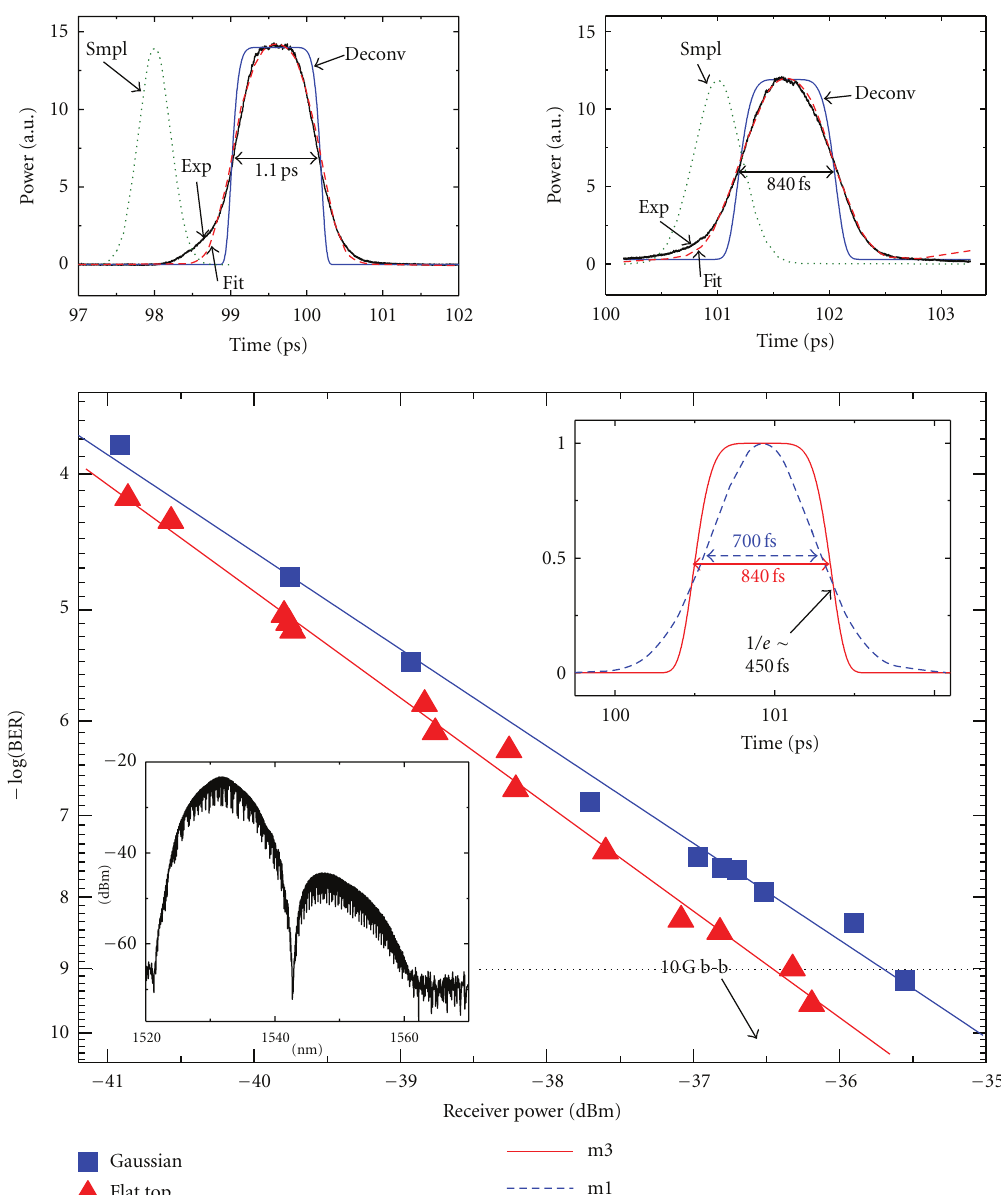
Figure 16: Flat-top pulses and 640Gbit/s demultiplexing with subpicosecond flat-top pulse. Top: measured cross-correlation traces of the generated flat-top pulses of various widths and deconvoluted waveforms. Bottom: BER performance with and without flat-top pulse. Insets show the spectral (lower left) profile of the flat-top pulse and the temporal (upper right) corresponding waveforms of the flat-top super- Gaussian (or order M = 3) and Gaussian ( m = 1) control